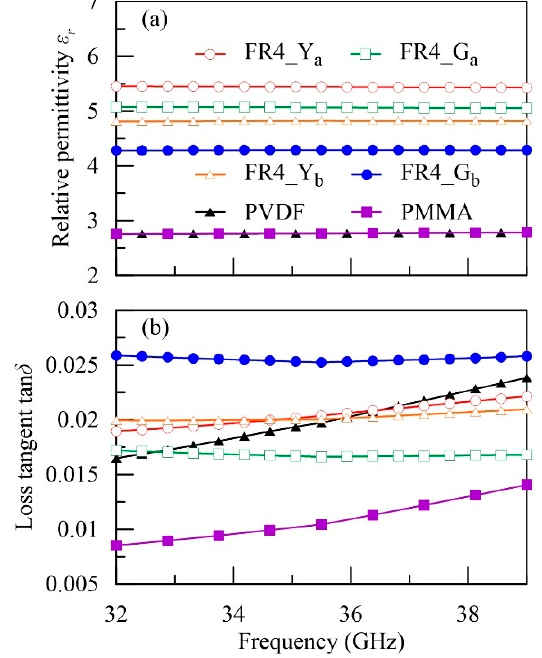
Figure 5. ( a ) Relative permittivity and ( b ) loss tangent of the high-loss materials. Table 1. The dielectric properties of the plastics at 36 GHz.